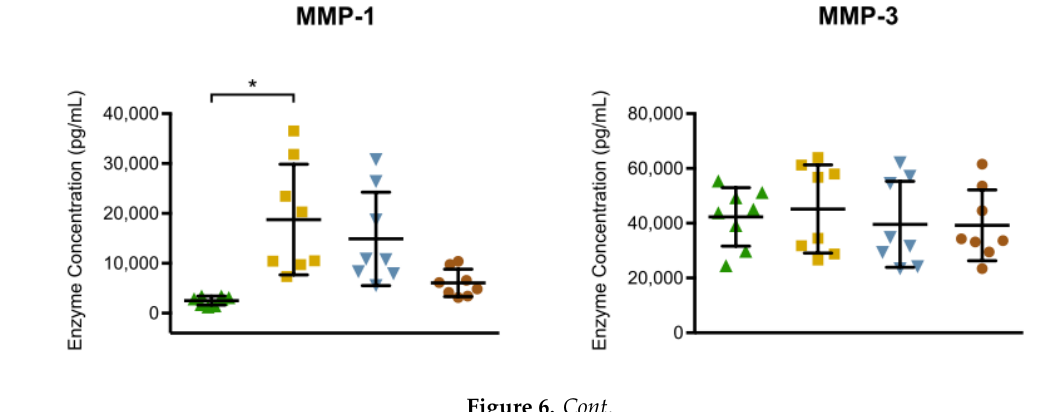
Figure 6. Quantitative analysis of MMP-1/-3/-9 and ADAMTS-5 concentration in chondrocyte monocultures and co-cultures with different CD4 + mononuclear cell subtypes is displayed. Chondrocytes harvested from tibial plateau of patients with advanced knee OA were isolated. A population of CD4 + CD127 dim/- -enriched PBMC and two subpopulations consisting of CD4 + CD25 - CD127 dim/- -enriched PBMC (Treg-depleted enriched PBMC) and CD4 + CD25 + CD127 dim/- Treg were isolated from heparin anti-coagulate peripheral blood using Ficoll-PlaqueTM and magnetic activated cell sorting. Chondrocytes monocultures and co-cultures were incubated for 48 h at 37 °C and then enzyme concentrations in culture supernatants were analyzed performing enzyme-linked immunosorbent assays. The mean and standard deviation of enzyme concentrations of MMP-1/-3/-9 and ADAMTS-5 are plotted ( n = 8). Significant differences are indicated by asterisks: * p < 0.05. 4. Discussion There is substantial evidence that metalloproteinases (MMP and ADAMTS), which are capable of degrading collagen and aggrecan as the main extracellular components of hyaline cartilage, are significantly involved in OA pathology [11–15]. However, it is still largely unknown which cell types and enzymes are mainly responsible for the catabolic and enzymatic turnover in OA disease. In particular, the role of T cells and whether they amplify the release of cartilage-degrading enzymes and are thus actively involved in OA progression is yet unknown. The overarching goal of this study was to analyze the impact of synovial cells and especially synovial macrophages and T cells on the release of MMP (MMP-1,-3,-9, and -13) and ADAMTS (ADAMTS-4,-5, and -7) in order to determine their inflammatory chondrodestructive potential in OA pathology. While previous studies suggest that MMP-13 and ADAMTS-4/-7 are involved in OA pathology [14–16], concentrations of these enzymes in supernatants of synovial cell cultures were mostly below